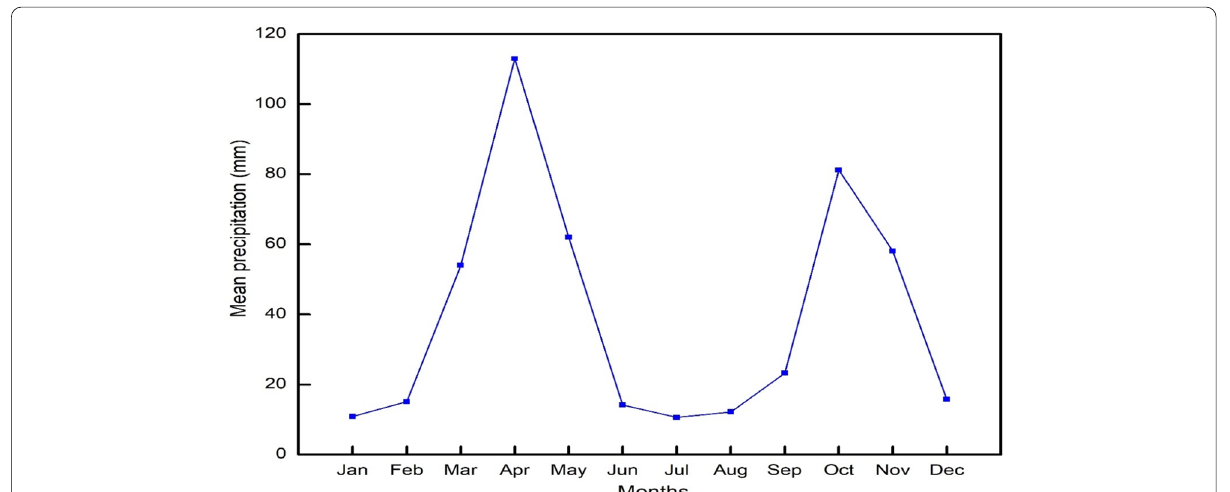
Fig. 3 Mean monthly precipitation in semi-arid Borana (1981–2018)